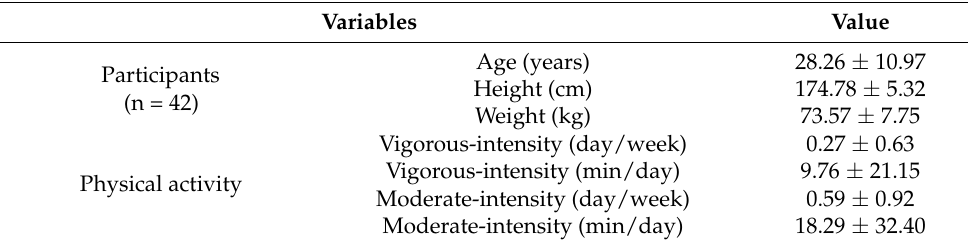
Table 1. Physical characteristics of the